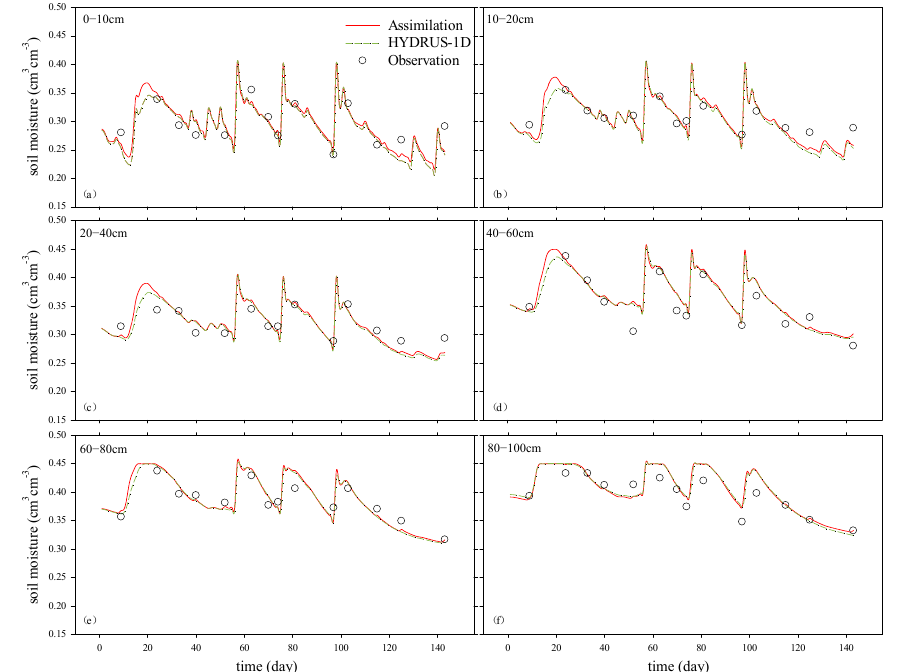
Figure 3. Simulated soil moisture at different depths with assimilation of only the soil moisture. (Green dashed lines represent the simulated results from Ren et al. [34] obtained using HYDRUS-1D; red solid lines represent the assimilation results).